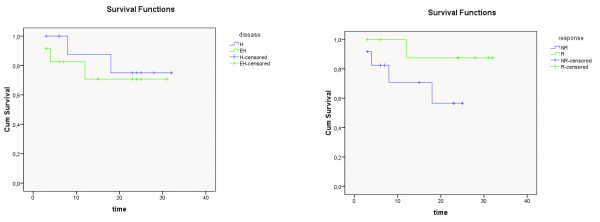
Cumulative survival curves of the R, NR, H and EH subgroups in the colorectal group. Time: months, R: responder, NR: nonresponder, H: hepatic, EH: extrahepatic.